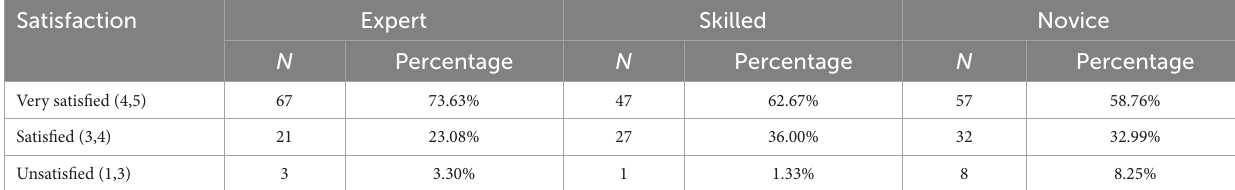
TABLE 7 Students’ satisfaction with expert, skilled, and novice teachers ( N =